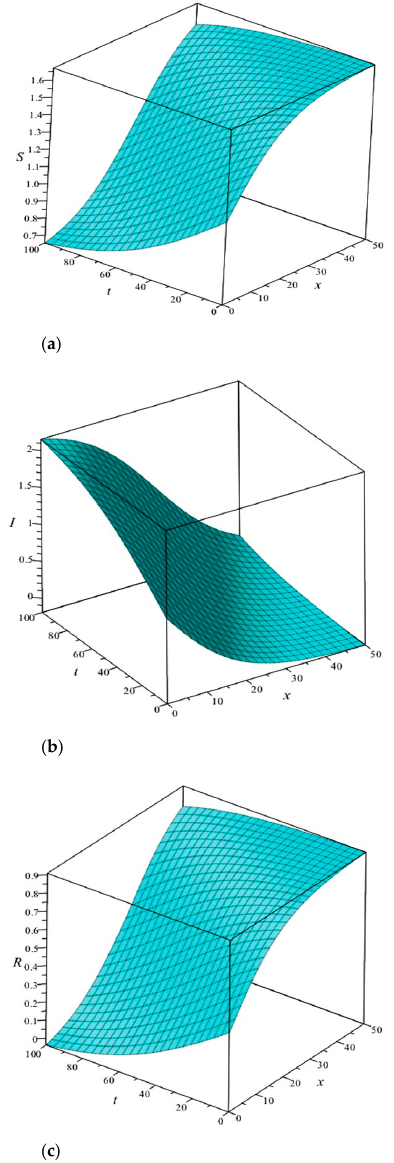
Figure 3. Three dimensional plots: ( a ) S ( x , t ) ; ( b ) I ( x , t ) ; ( c ) R ( x , t ) . The plots of the analytical solutions of (5)–(8) with the same set of parameters as those shown in Figure 2.